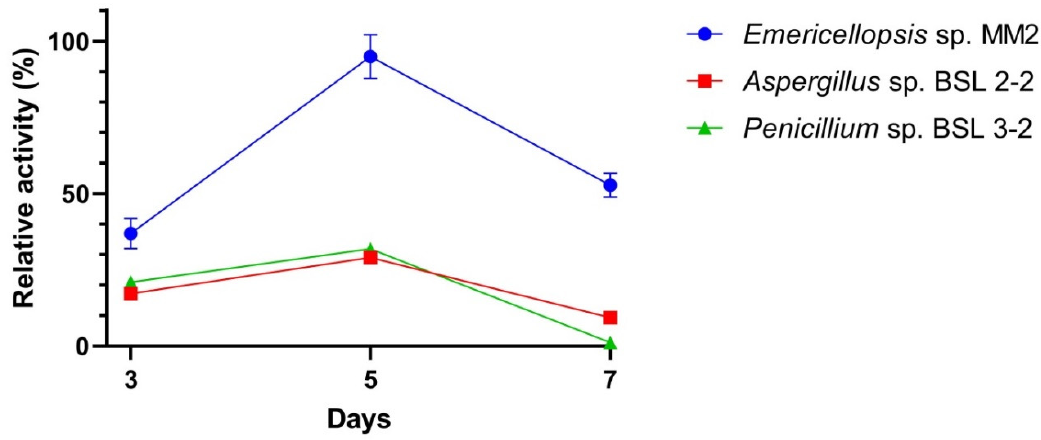
Figure 6 . Lipase activity in the crude extracts of the fungal strains after 3, 5, or 7 days of